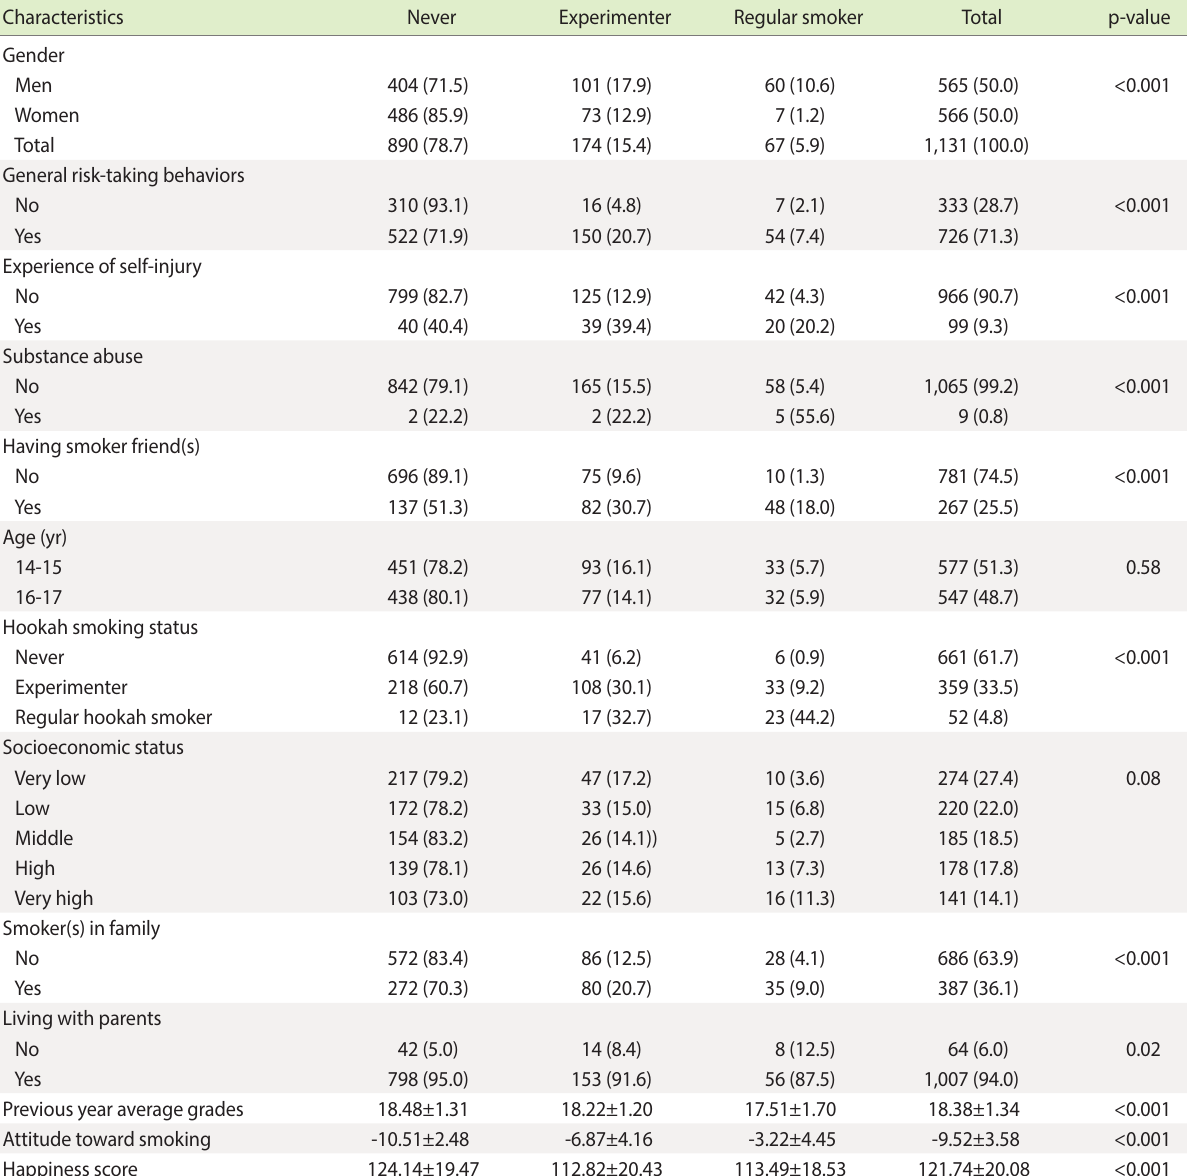
Table 1. Demographic and other characteristics of the students according to cigarette smoking status Characteristics Never